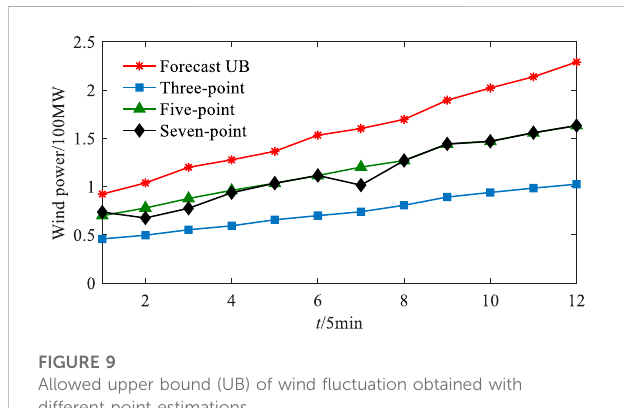
FIGURE 9 Allowed upper bound (UB) of wind fl uctuation obtained with different point estimations.